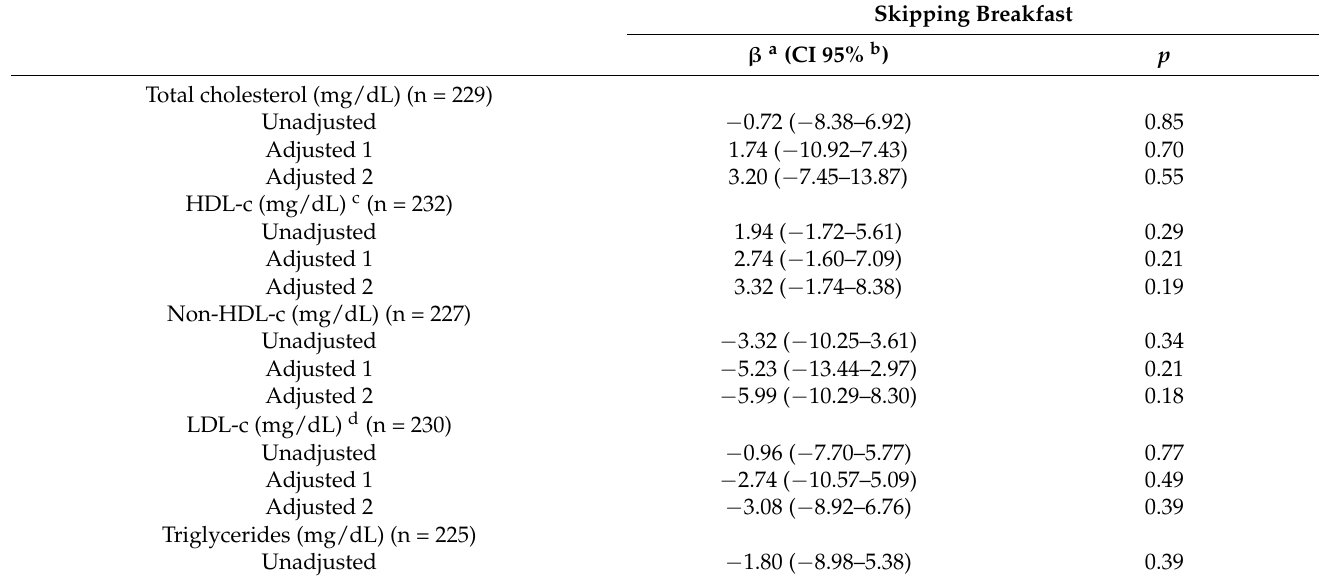
Table 5. Cross-sectional associations between skipping breakfast and cardiometabolic and nutritional parameters of children and adolescents with CHD. Brazil